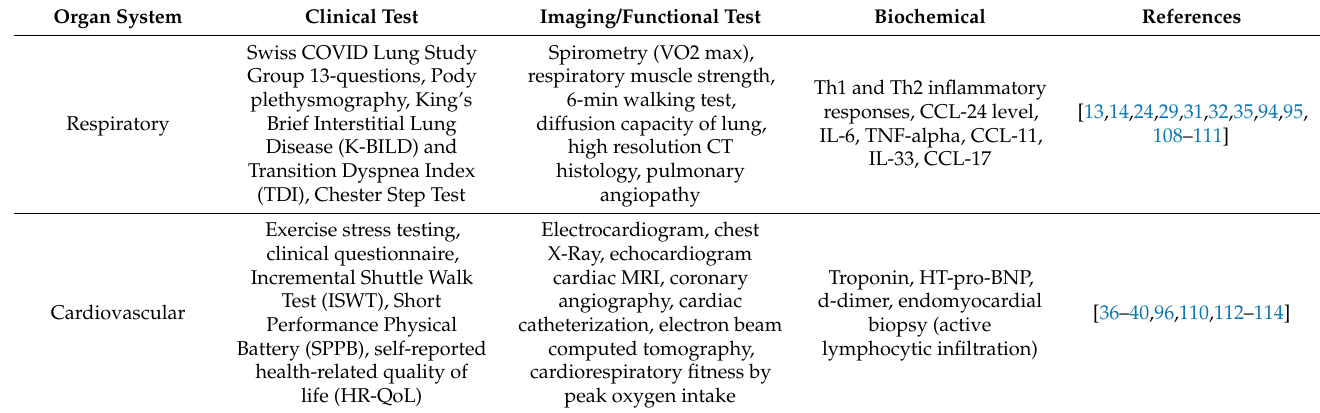
Table 3. Summary of PC19S clinical, imaging and biochemical markers for diagnosis and prognosis in various studies